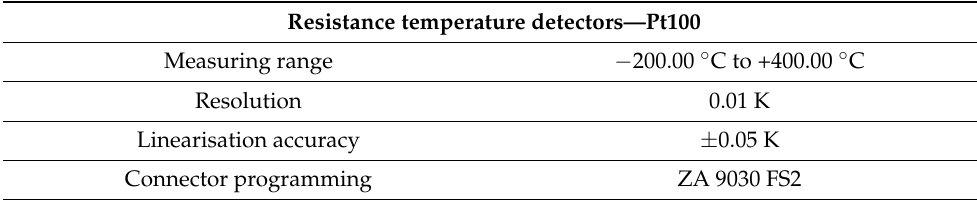
Table 4. Thermocouple